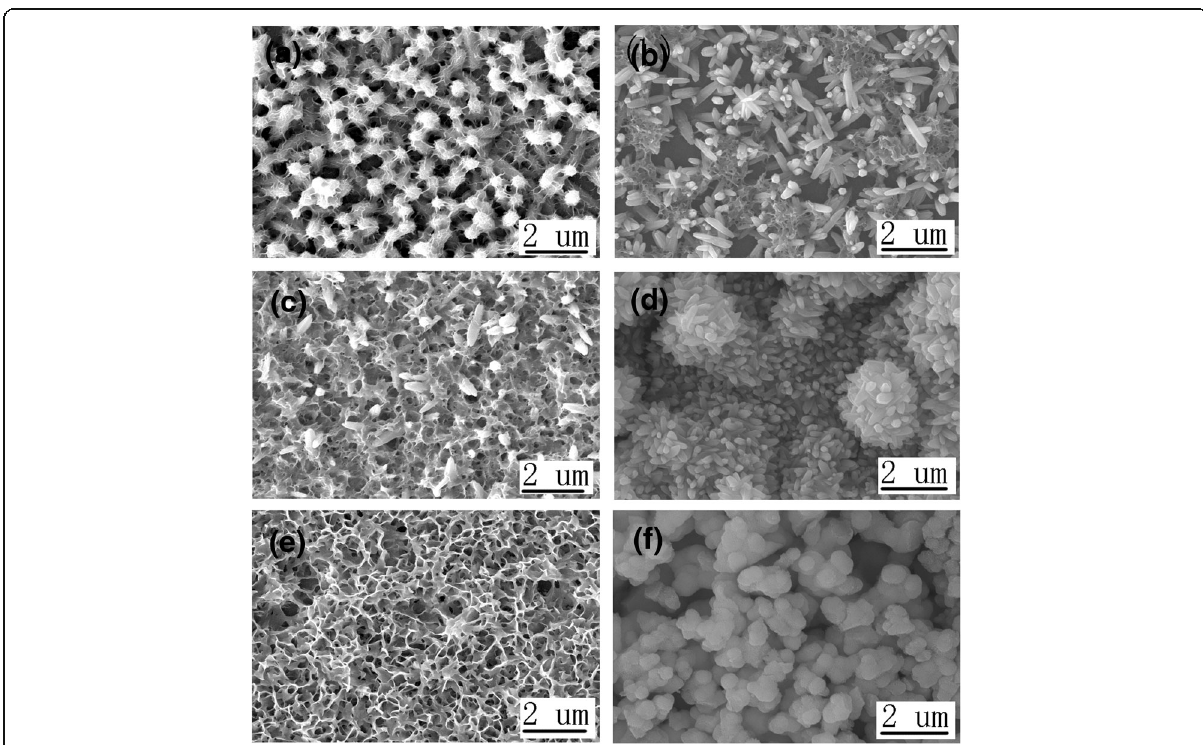
Fig. 5 The top view SEM image of ZnO/NiO (1 min) heterojunction ( a ), ZnO/NiO (10 min) heterojunction ( b ), NiO (1 min)/ZnO heterojunction ( c ), NiO (10 min)/ZnO heterojunction ( d ), NiO (1 min) ( e ), and NiO (10 min) ( f